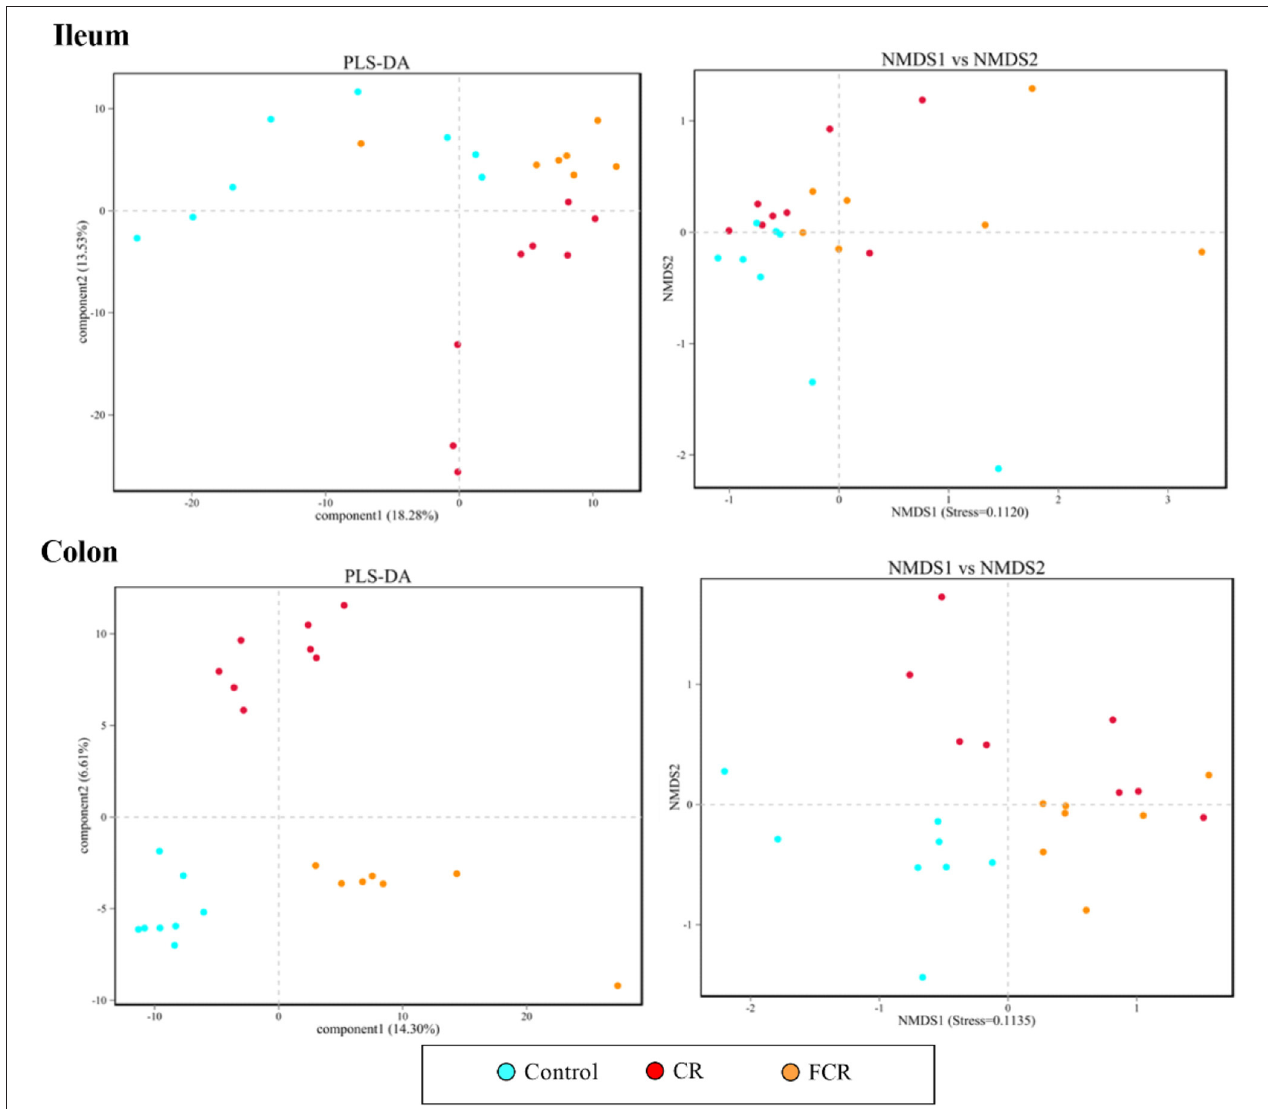
FIGURE 1 | Partial least squares discriminant analysis (PLS-DA) and nonmetric multidimensional scaling (NMDS) analyses of the bacterial community in the ileum and colon of piglets. Each symbol represents the gut microbiota from one piglet, represents the piglets in the control group, represents the piglets in the CR group, and represents the piglets in the FCR group ( n =